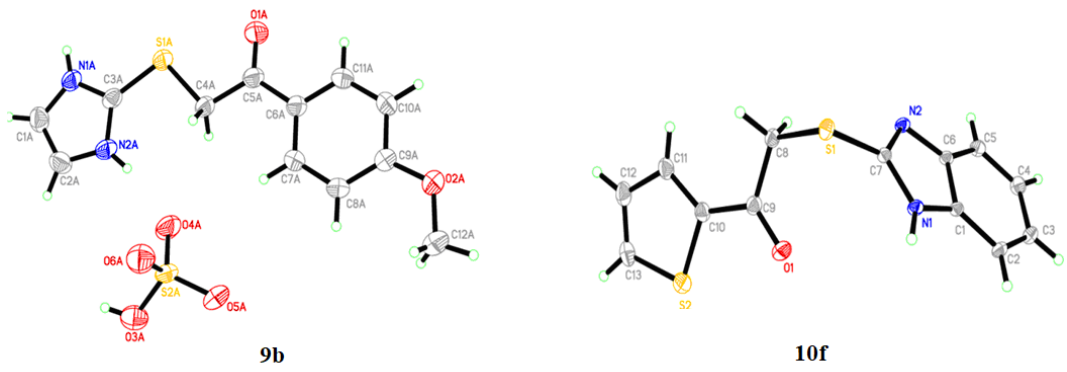
Figure 2. Oak Ridge Thermal Ellipsoid Plot (ORTEP) diagrams for imidazole sulfate-salt 9b and benzimidazole derivative 10f . Displacement ellipsoids have been plotted at the 40% probability level for non-H atoms.